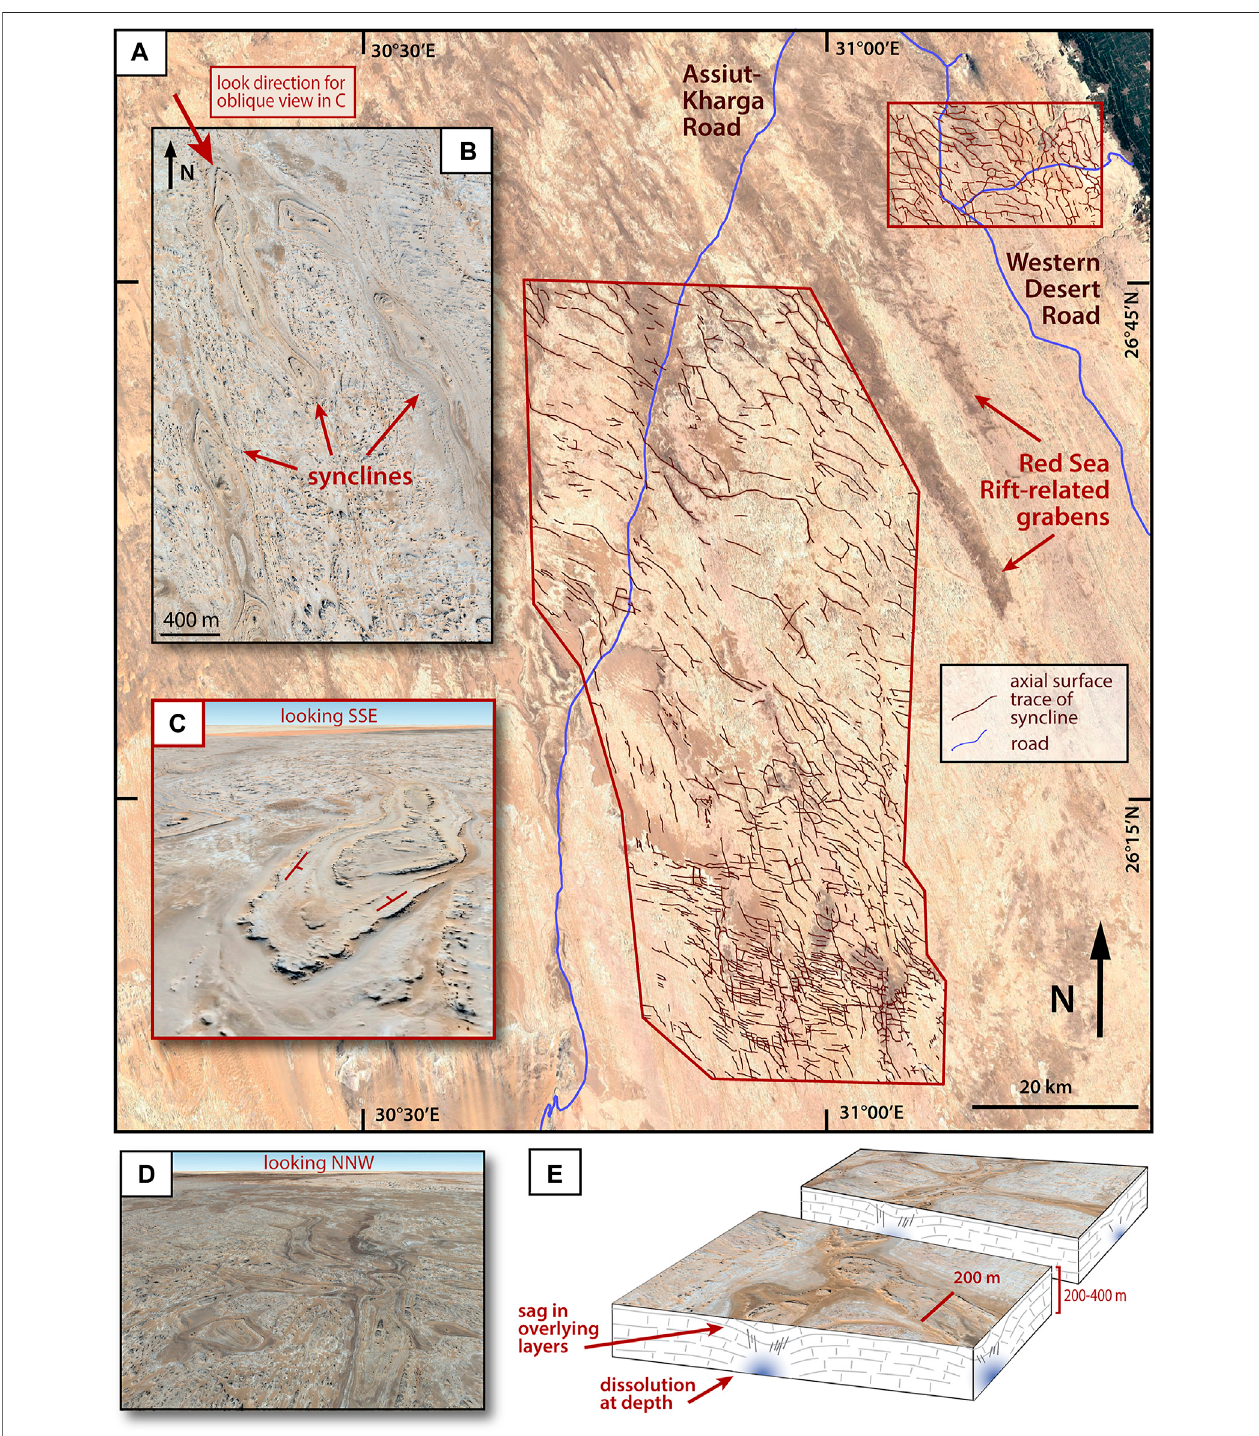
FIGURE 2 | Previous results of our syncline network mapping (Tewksbury et al., 2017a). (A) Brown lines show axial surface traces of synclines in the network. (B) Synclinesoccurasdownwarpsinotherwise fl at-lyinglimestonesandhaveshallowlimbdips,porpoisinghinges,andmultiplebasinclosuresalongtrend. (C) Obliqueview looking SSE across syncline shown with red arrow in 2A; shows shallow inward dips of layers. (D) Synclines include both small isolated singlets and long synclines that branch,curve,and mergewithoneanothertoform anetwork. (E) ModelfororiginofsynclinenetworkproposedinTewksburyetal.(2017a)involving dissolutionat depth in limestone and syncline formation by sag in overlying limestone layers. Image source: Google Earth. Coordinates for Google Earth images: B) 26.200966, 30.979914; C) 26.215634, 30.972404; D) 26.210351, 30.924365; E) 26.053406, 30.954647.